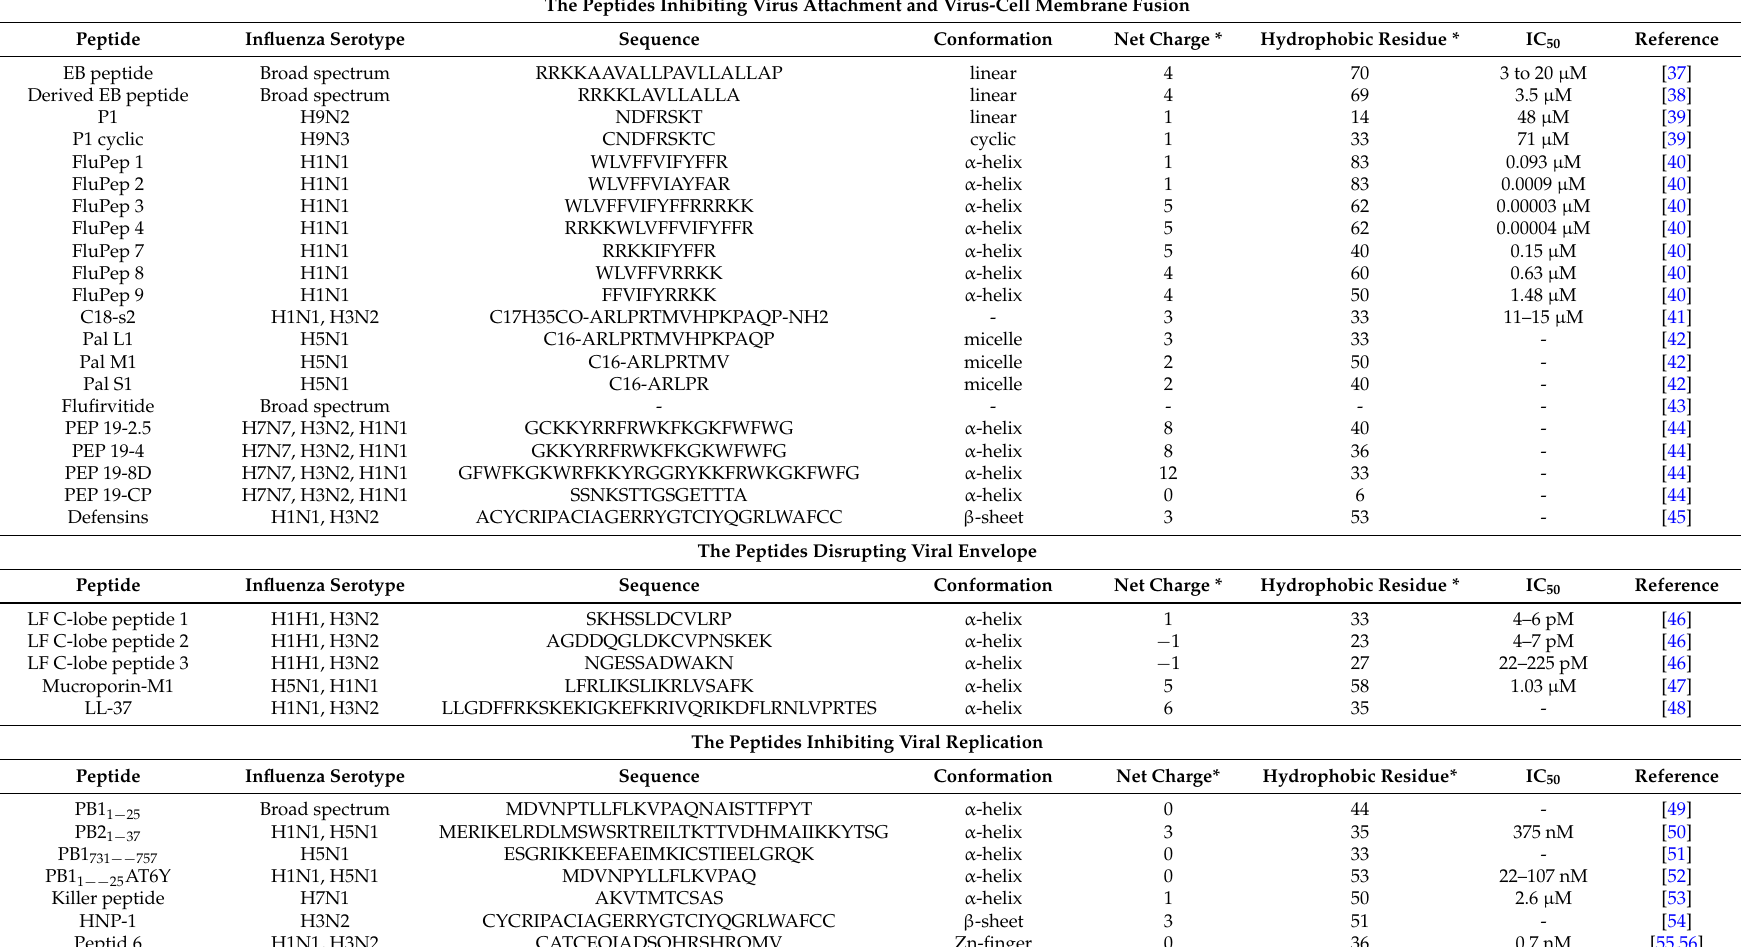
Table 1. List of antiviral